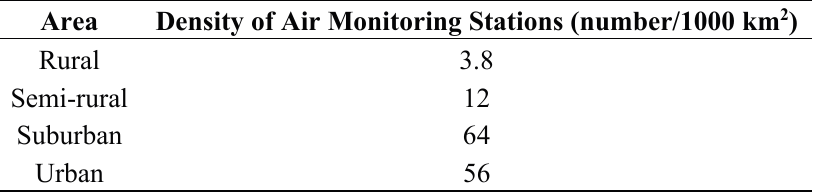
Table 2. Density of monitoring stations in each